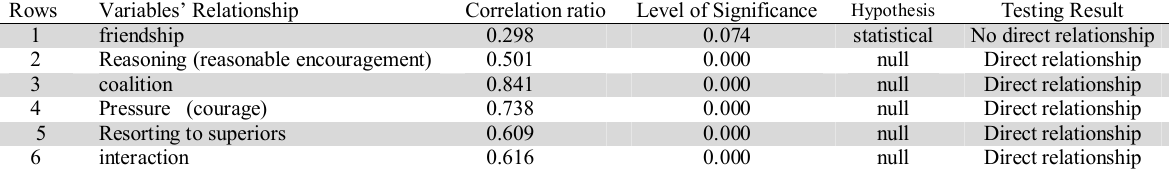
Correlation matrix between manager’s six tactics and influencing female